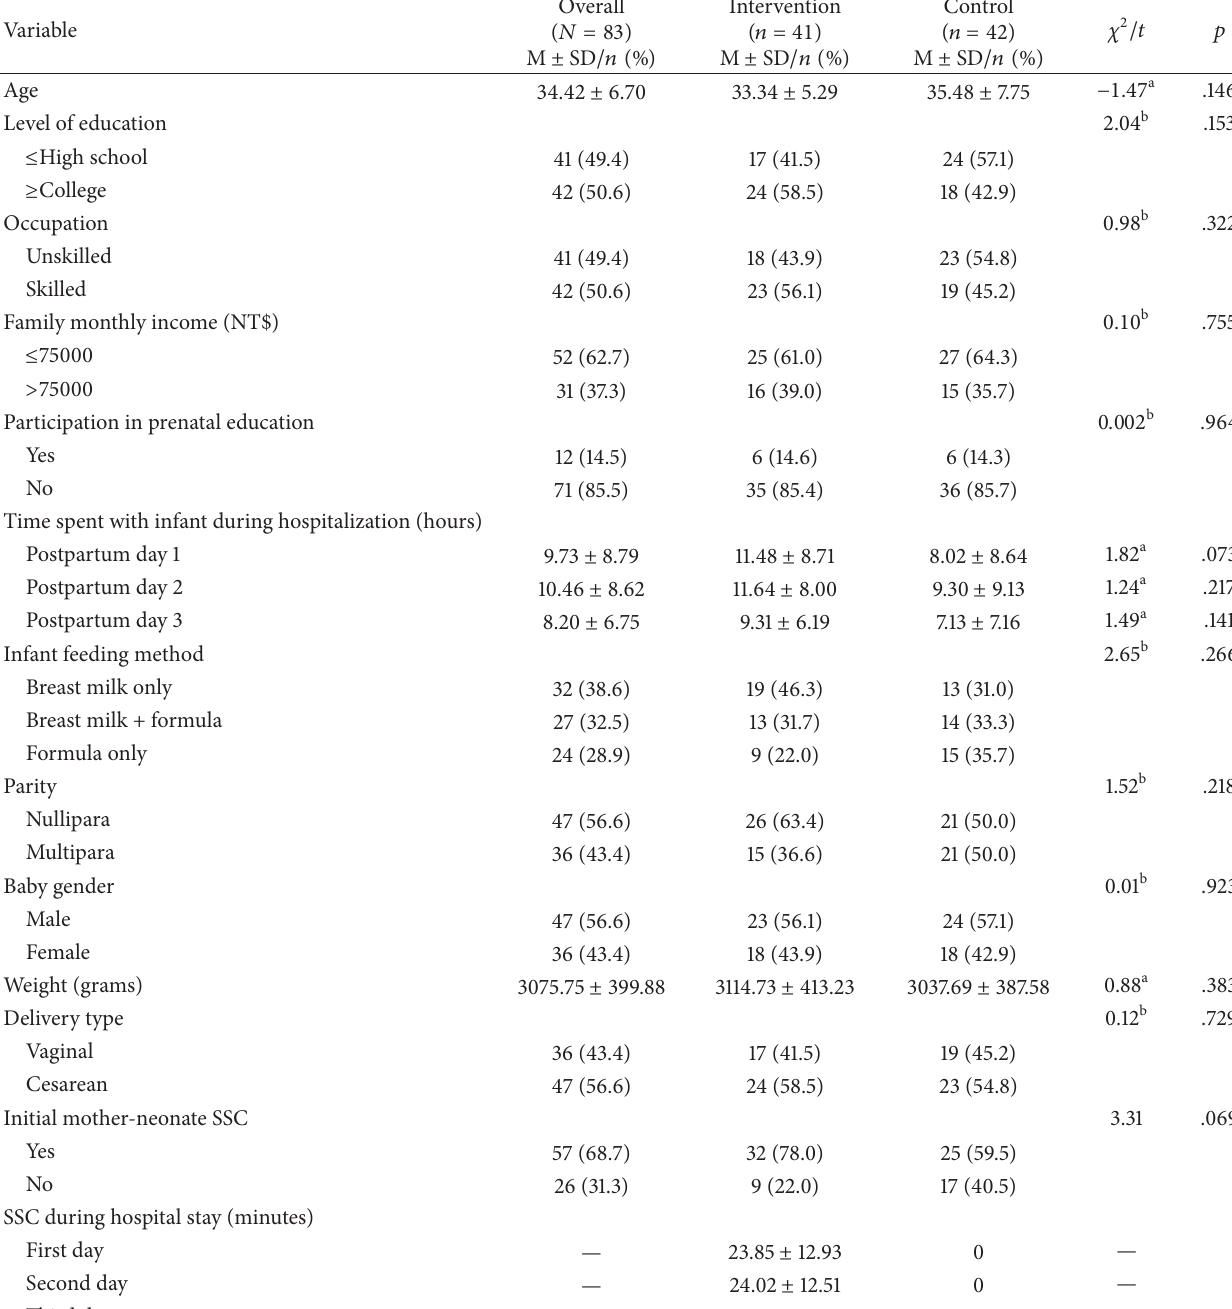
Table 1: Comparative demographic variables, intervention, and control